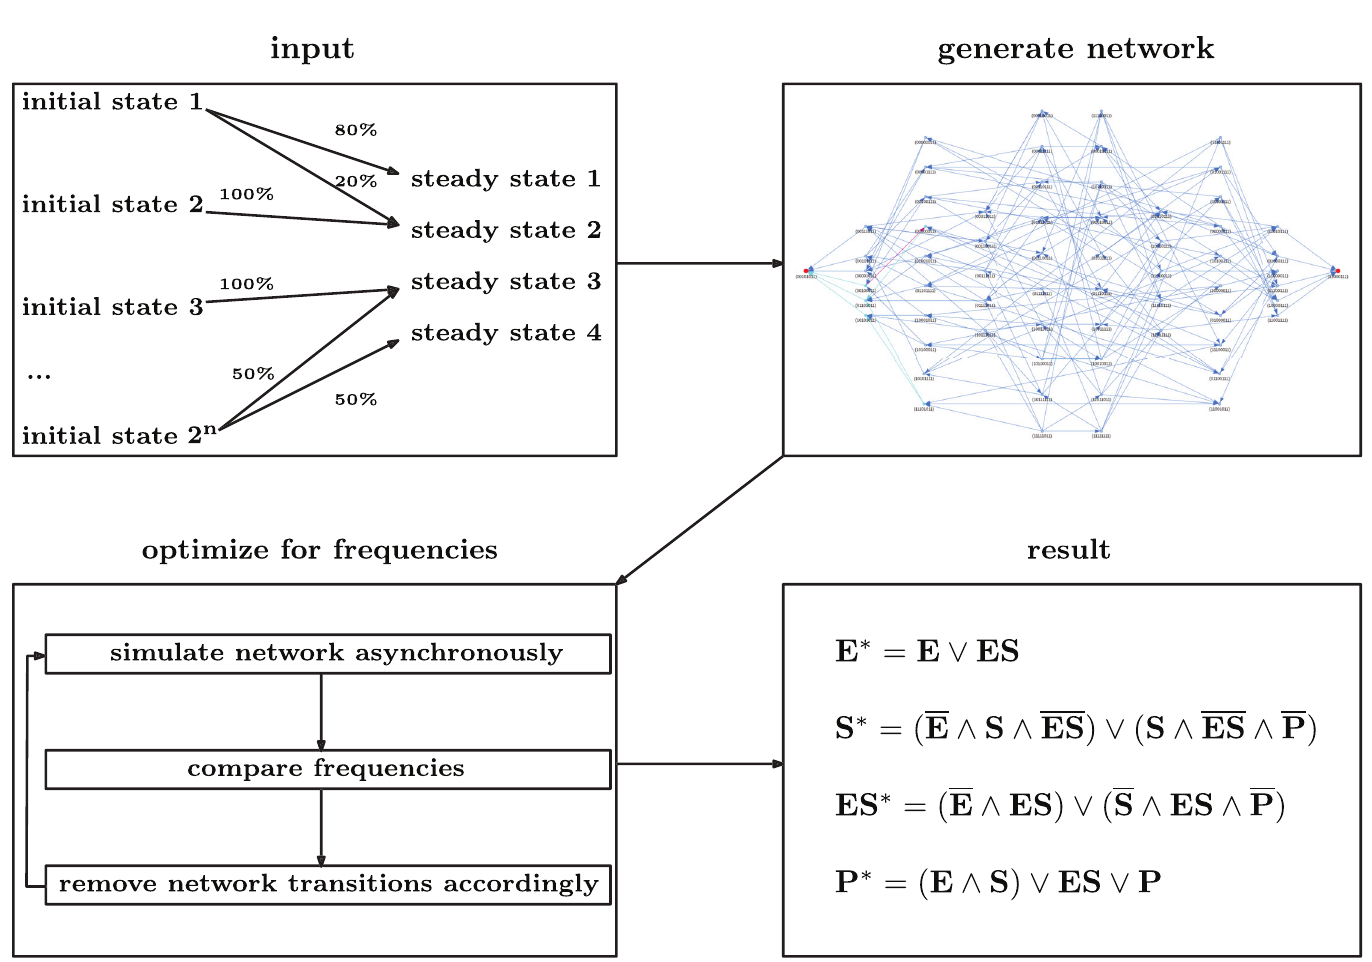
Fig 1. Schematic depiction of our workflow. Our input data is of the form initial state and corresponding steady states. If the same initial state is observed to end up in multiple steady states, a probability to reach each steady state can be prescribed as well. From the initial state to attractor relationship, a network is created using the state transition graph, taking into account every possible connection allowed by an asynchronous updating scheme. We then simulate the network and compare the resulting probabilities to the specified measurement data. If necessary, we remove transitions from the network to achieve a better match between the probabilities of the resulting network and the the experimental data. The result is a system of Boolean rules that describes the network